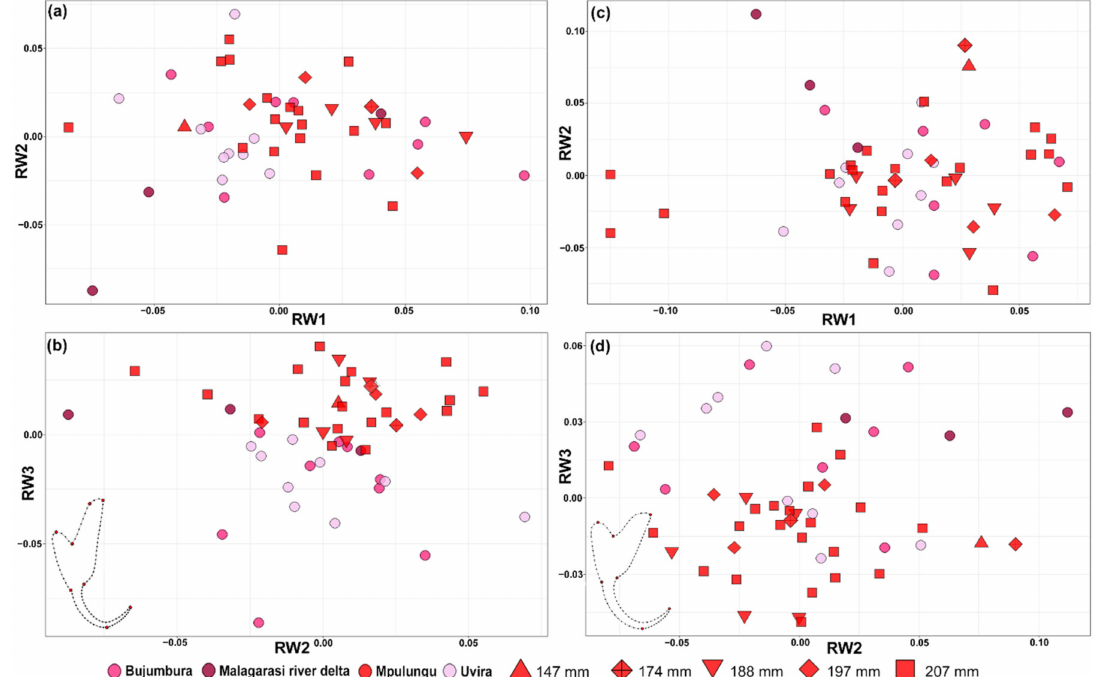
Figure 3. Biplots showing the shape variation in anchors of Cichlidogyrus casuarinus ex Hemibates stenosoma . Only the first three axes are shown. ( a , b ) RWA of the dorsal anchor using a semi-landmark sliding approach. ( c , d ) RWA of the ventral anchor using a semi-landmark sliding approach. Consensus shape displaying the position of fixed (red dots) and semi-landmarks (black dots) in dorsal and ventral anchors, respectively, is